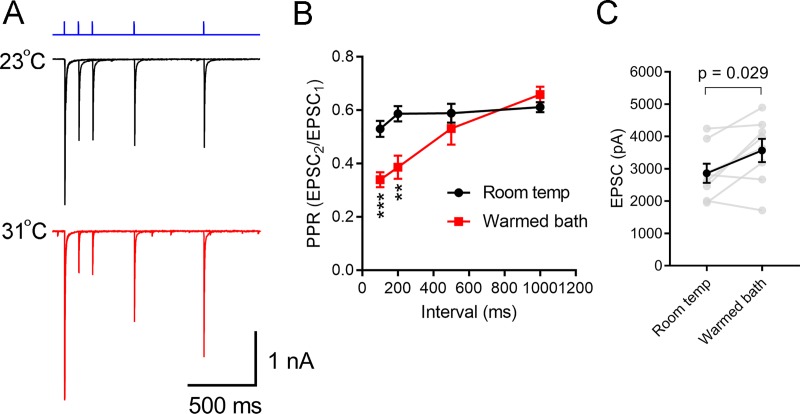
Influence of temperature on short-term plasticity of retinogeniculate synapses.A) Overlaid voltage-clamp recordings from a TC neuron from a Chx10-Cre;Ai32 mouse in response to pairs of 460 nm LED stimuli with intervals of 100, 200, 500, and 1000 ms (blue) at 23°C and 31°C in the presence of 200 μM γDGG and 100 μM cyclothiazide. Recordings were made in the presence of γDGG (200 μM) and cyclothiazide (100 μM). B) Plot of paired pulse ratio (PPR = EPSC2/EPSC1) showing that synaptic depression was increased following warming of the bath solution (n = 6). **p<0.01; ***p<0.001, t-test. C) Measurements of EPSC amplitude at room temperature and in warmed conditions (n = 8).